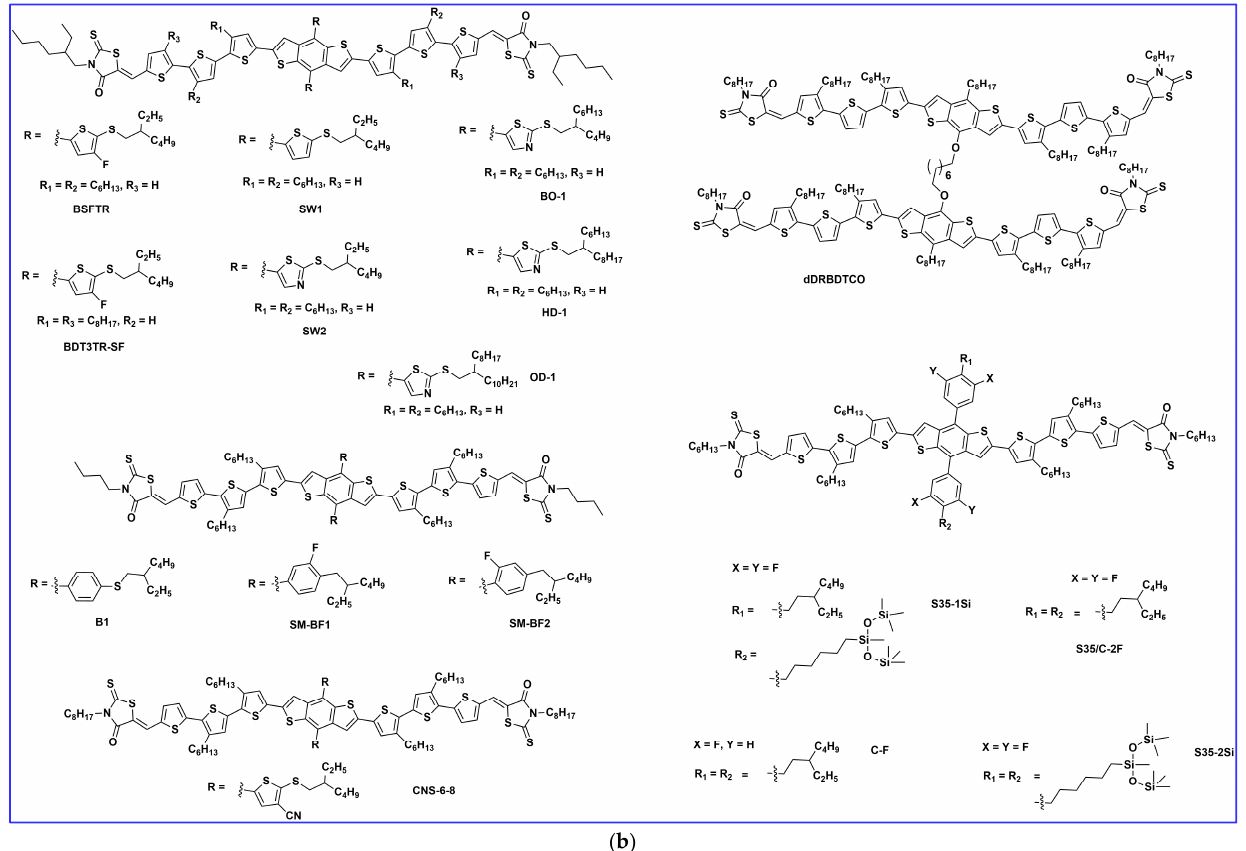
Figure 3. ( a ) BDT molecular structure via lateral side chain engineering. ( b ) BDT molecular structure via lateral side chain engineering. Table 1. Optoelectronic properties and device parameters for BDT-based ASM OSCs via lateral side chain